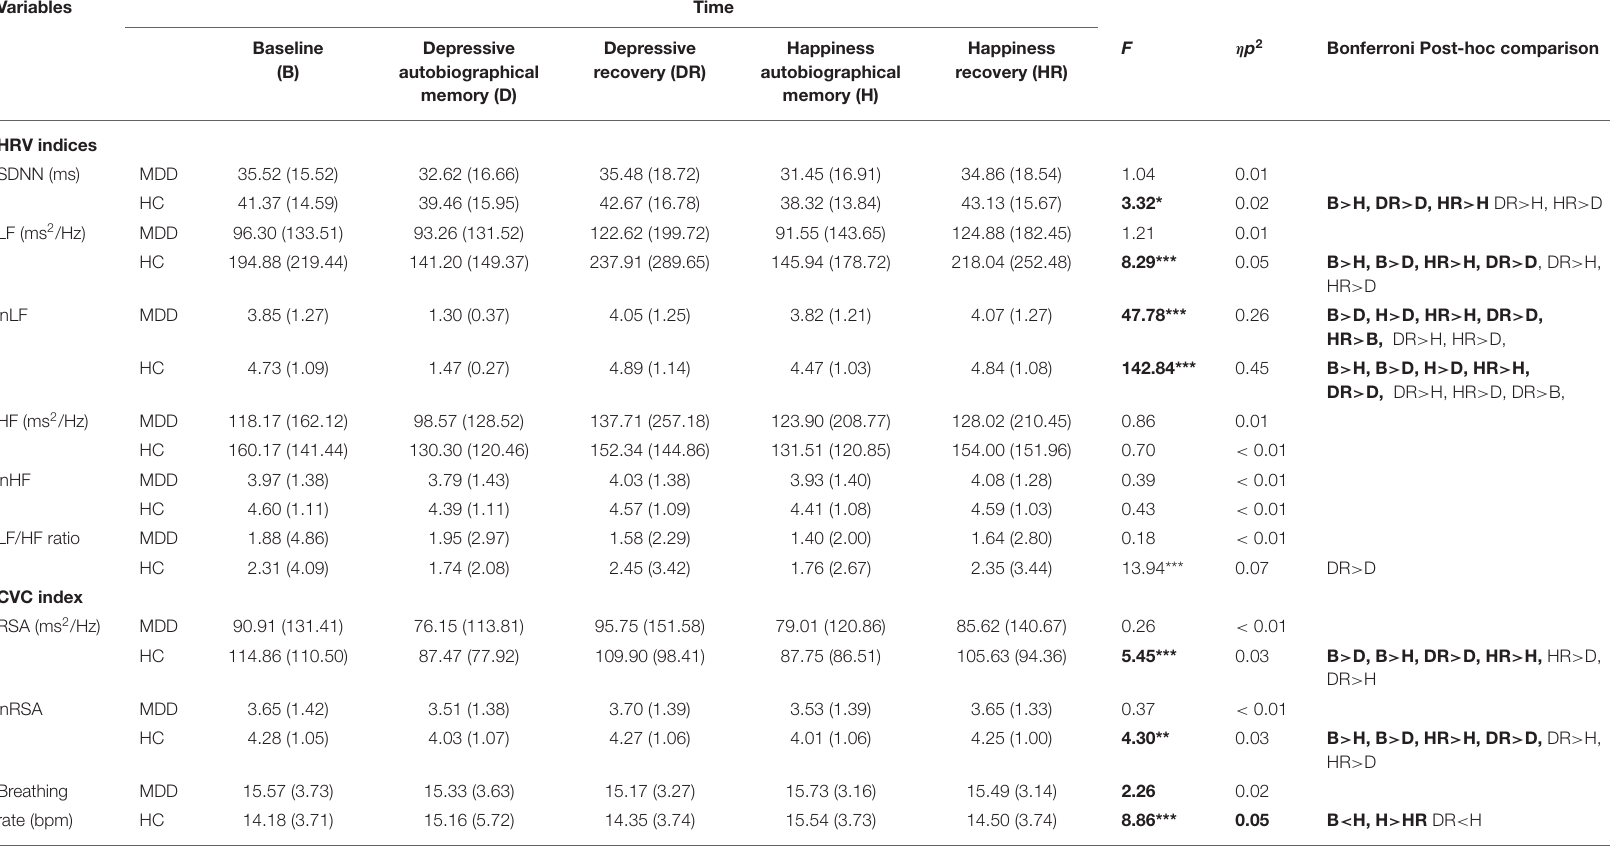
TABLE 2 | One-way repeated measure ANOVA at different experimental stages between the MDD and HC groups in HRV and CVC indices.